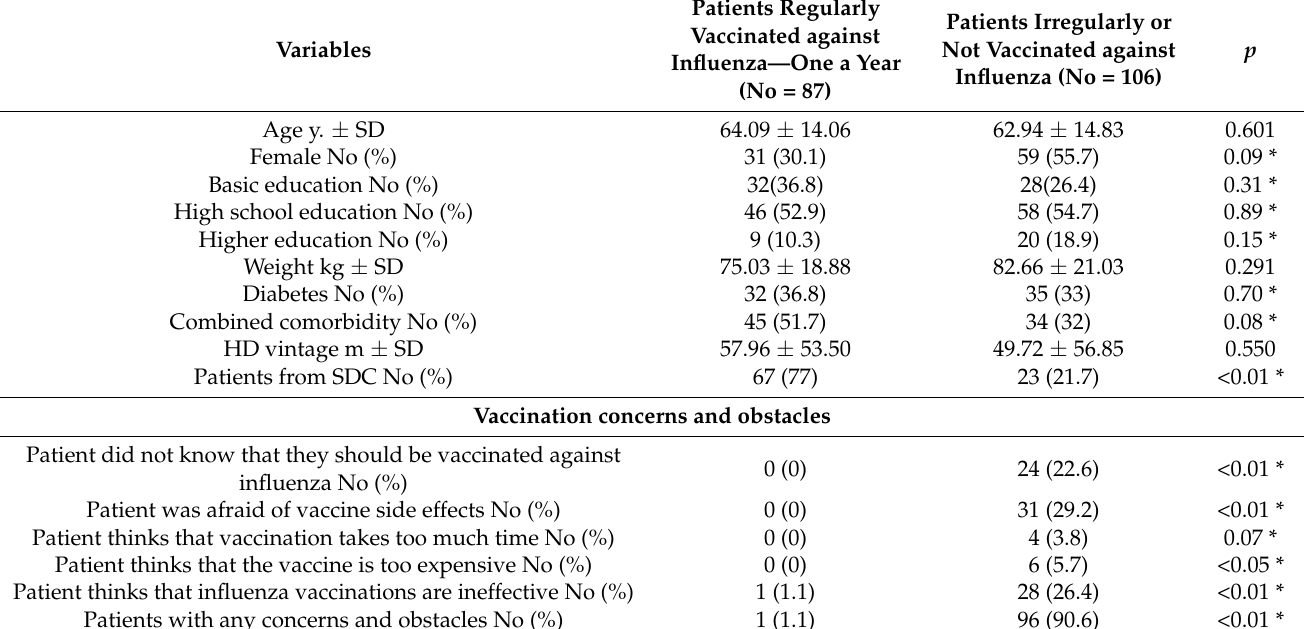
Table 2. Baseline characteristics of the study